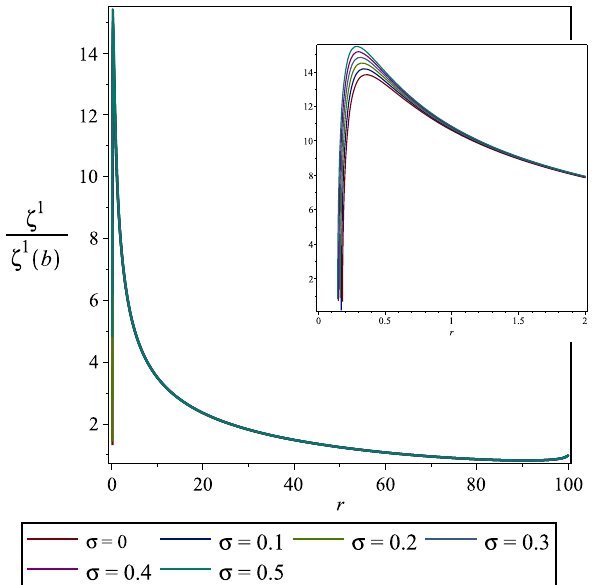
Fig. 8 Radial components of geodesic deviation for a Kiselev BH sur- rounded by dust with IC2 for different values of the dust parameter with M = 1, q = 0 . 6 and b = 100 ˆ i ( ˙ ζ ˆ i ( b ) > 0, b ) = 0. It represents releasing of a and ζ